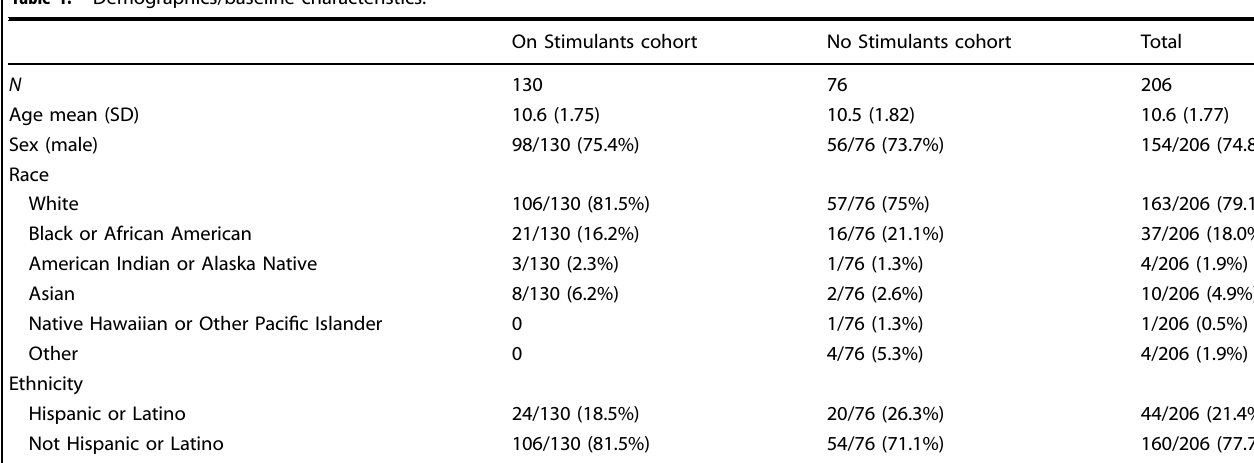
Table 1. Demographics/baseline characteristics.